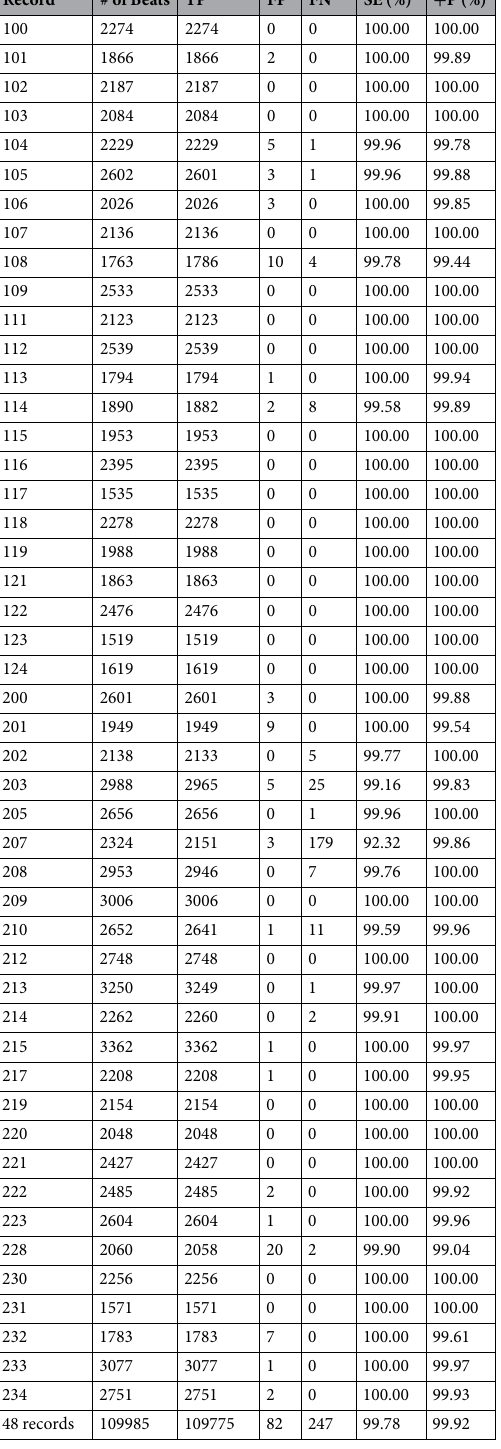
Table 2. Performance of Method III using B / K = 4.875 on the MIT-BIH arrhytmia database. The results were obtained using the optimal values of B and K , which are 390 Hz and 80 Hz, respectively. TP stands for true positives (the number of QRS complexes detected as QRS complexes), FN stands for false negatives (the number of QRS complexes which have not been detected), FP stands for the number of false positives (non-QRS complexes detected as QRS complexes), SE stands for sensitivity, and + P stands for positive